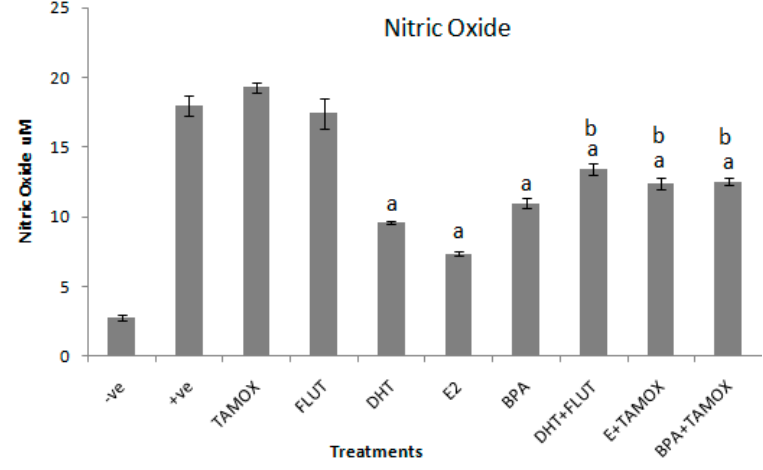
Figure 2. E ff ects of DHT, E2, and BPA alone and in combination with tamoxifen (TAMOX) or flutamide (FLUT) on secretion of nitric oxide (NO) in supernatant of RAW264.7 cells stimulated with 1 µ g / mL LPS. The stimulated cells were treated with 5 µ g / mL of DHT, E2, and BPA alone and 2 µ g / mL of flutamide or tamoxifen. Negative control was treated with normal medium and positive control treated with LPS (1 µ g / mL). The results are presented as mean ± SD; a -indicates that NO level is significantly ( p < 0.001) lower than the positive control; b -indicates that NO level is significantly ( p < 0.001) higher than levels of NO secreted by cells treated with DHT, E2, and BPA alone.